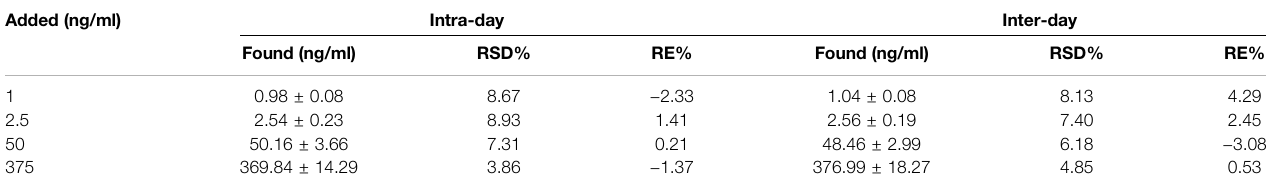
375 Recovery and matrix effect.